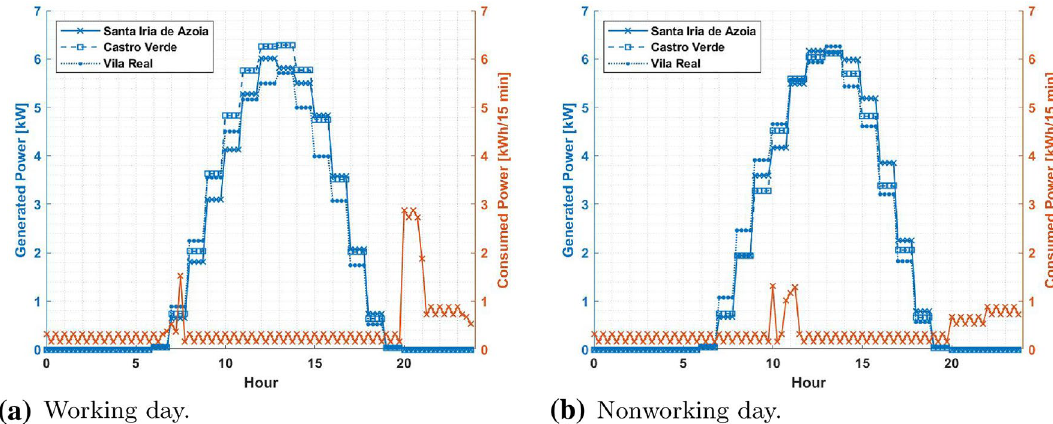
Fig. 18 Generation and consumption curves on the two significant days of August for CsPbI 3 QDs